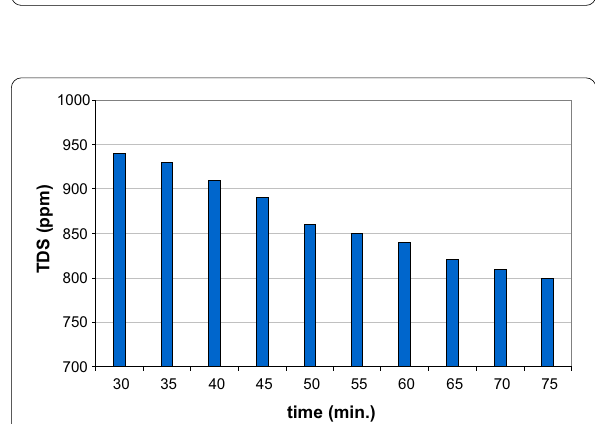
Fig. 10 Electrical conductivity versus time (30 min up to 75 min), by using brackish groundwater in case of closed cycle at flow rate of 52.16 l/min